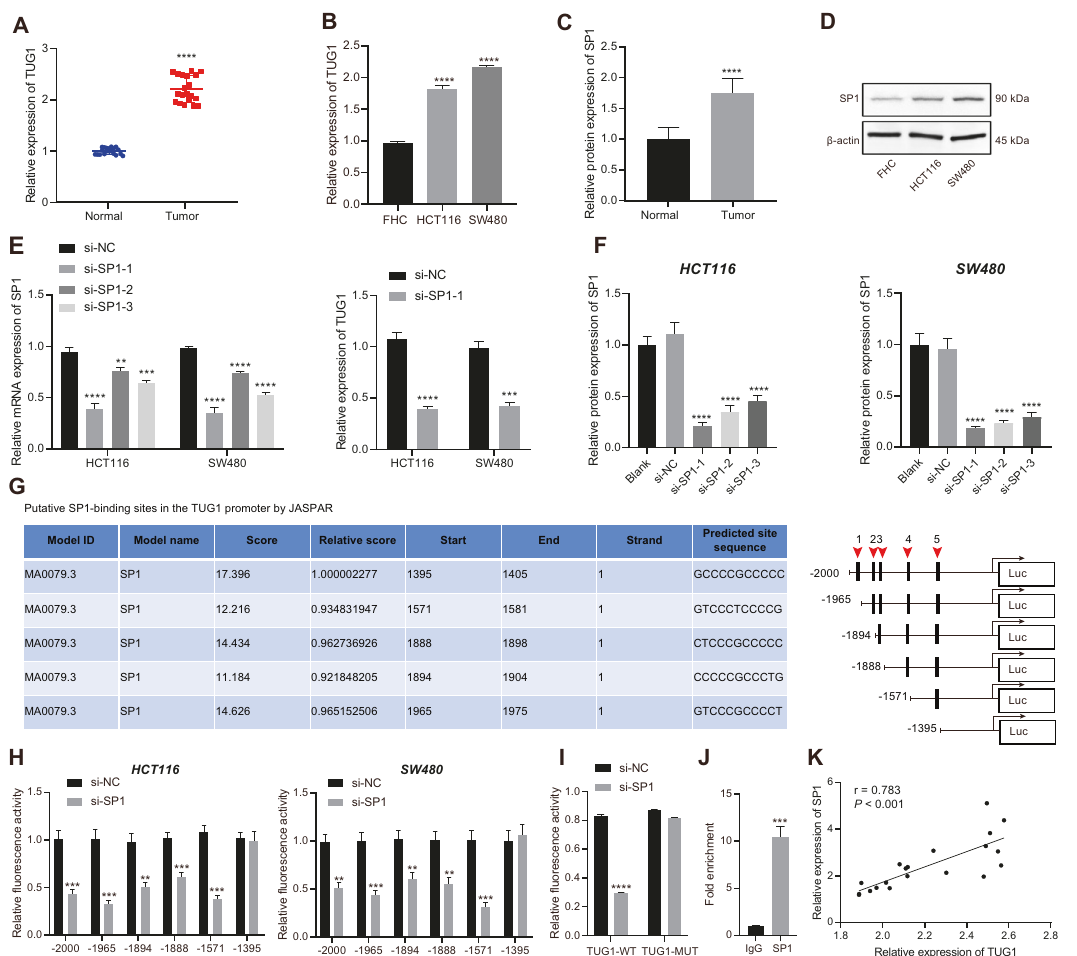
Fig. 1 SP1 and TUG1 are abundant in CRC and SP1 up-regulates the expression of TUG1 by binding to the promoter region of TUG1. A TUG1 expression in the CRC and adjacent normal tissues ( n = 20) determined by RT-qPCR. B TUG1 expression in normal human colonic epithelial cell line FHC and CRC cell lines HCT116 and SW480 determined by RT-qPCR. C SP1 protein level in the CRC and adjacent normal tissues ( n = 20) measured by Western blot assay. D SP1 protein level in the human normal colonic epithelial cell line FHC and CRC cell lines HCT116 and SW480 measured by Western blot assay. E SP1 mRNA expression in the HCT116 and SW480 cells transfected with si-SP1-1, si-SP1- 2 and si-SP1-3 determined by RT-qPCR. F SP1 protein level in the HCT116 and SW480 cells transfected with si-SP1-1, si-SP1-2, and si-SP1-3 measured by western blot assay. G The binding sites of SP1 in the TUG1 promoter region predicted by the JASPAR website. H After truncation of binding sites, the speci fi c binding site 5 of SP1 in the TUG1 promoter region was determined by dual-luciferase reporter assay. I